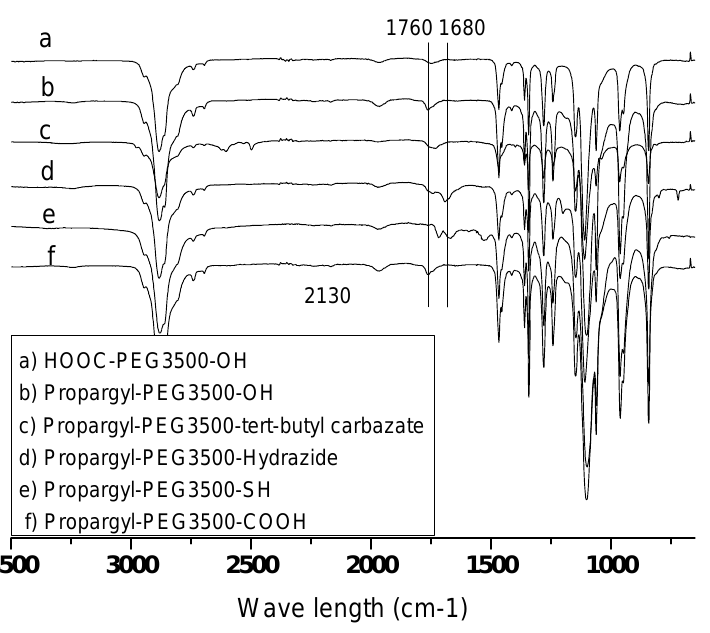
Figure 3. FT-IR spectra of bifunctional